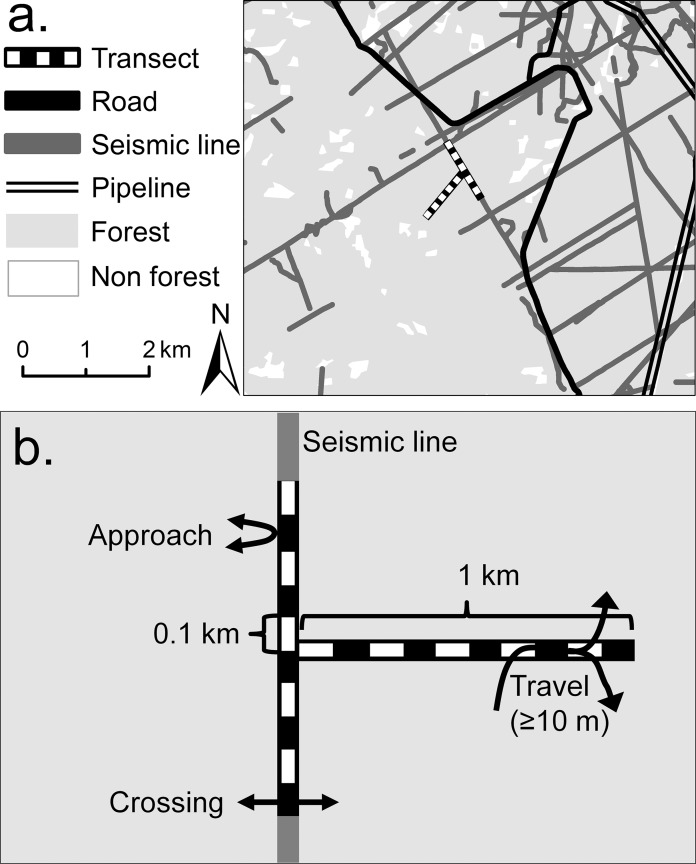
Example of site layout showing a typical landscape context, transect layout and three types of mammal movements recorded by this study.Example of a study site layout: (A) shows a typical landscape context and the paired seismic line (SL) and forest transects; (B) diagrams the transect details, including their division into 10, 0.1 km sub-transects and the three types of individual movement (approaches, crossings, or travels).